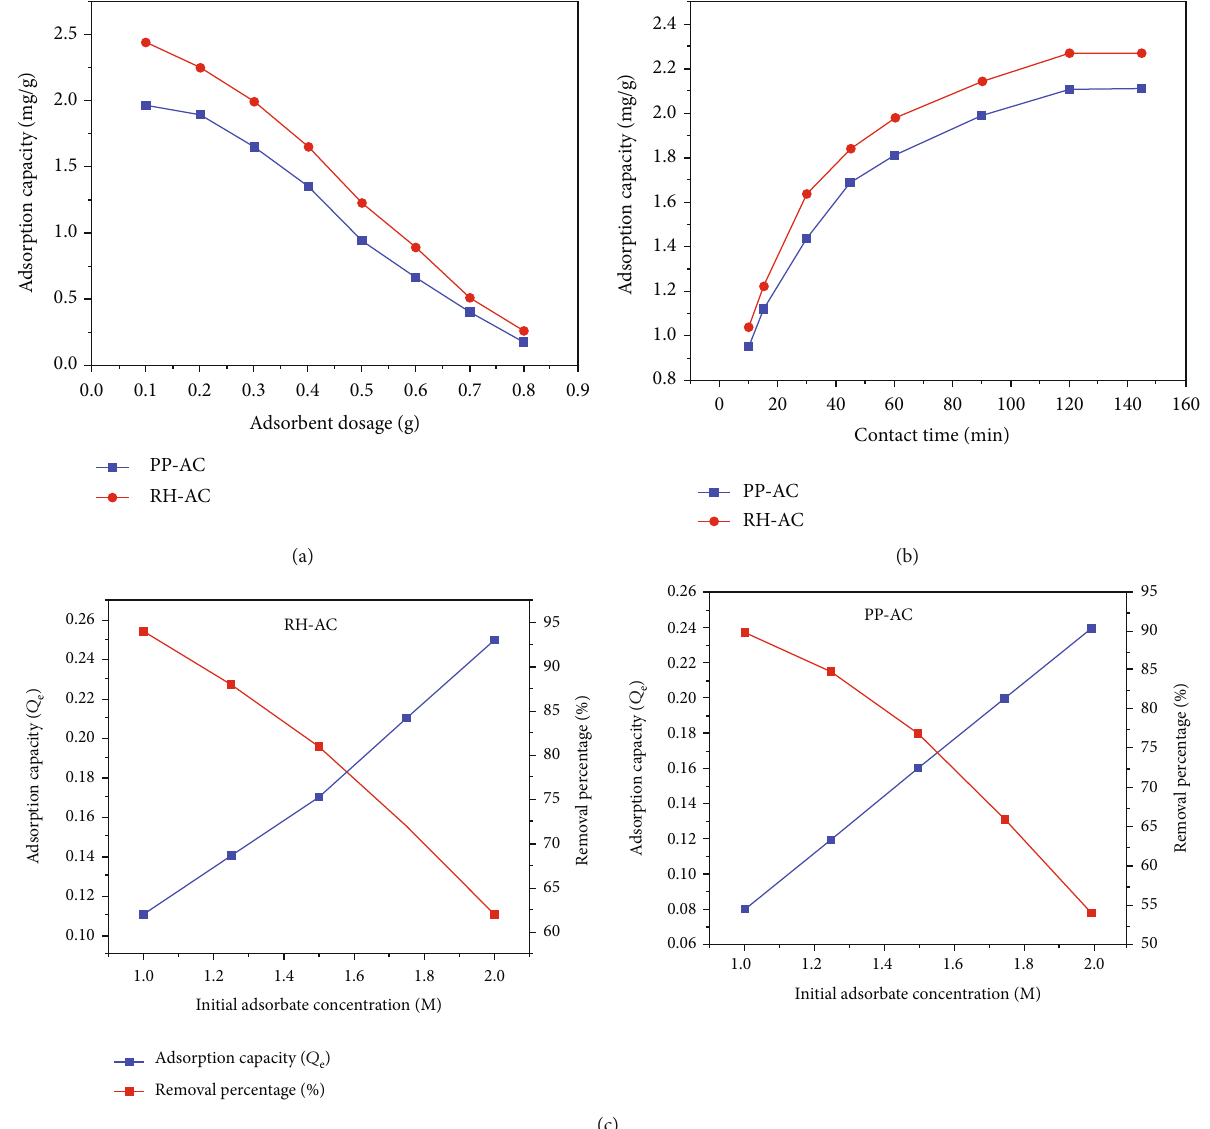
Figure 4: (a) The e ff ect of contact time on acetic acid adsorption onto RH-AC and PP-AC, at contact time 90, initial concentration of 1.5M, 0.1g/50mL, and agitation speed of 120rpm. (b) The e ff ect of adsorbent dosage on acetic acid adsorption onto RH-AC and PP-AC, contact time 90, initial concentration of 1.5M, and agitation speed of 120 rpm. (c) The e ff ect of adsorbate concentration on acetic acid adsorption onto RH-AC and PP-AC, contact time 120min, adsorbent dose 0.1g/50mL, agitation speed of 120rpm, and